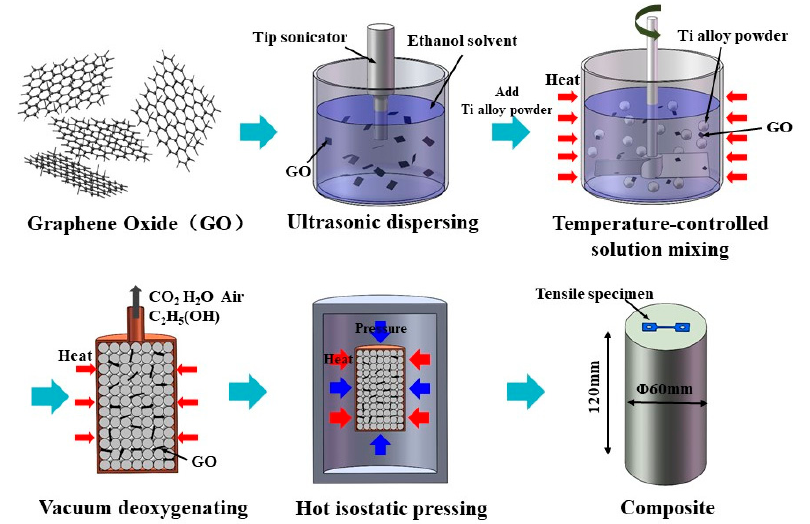
Figure 2. Schematic of GO-reinforced high-temperature titanium-alloy-matrix composite fabrication